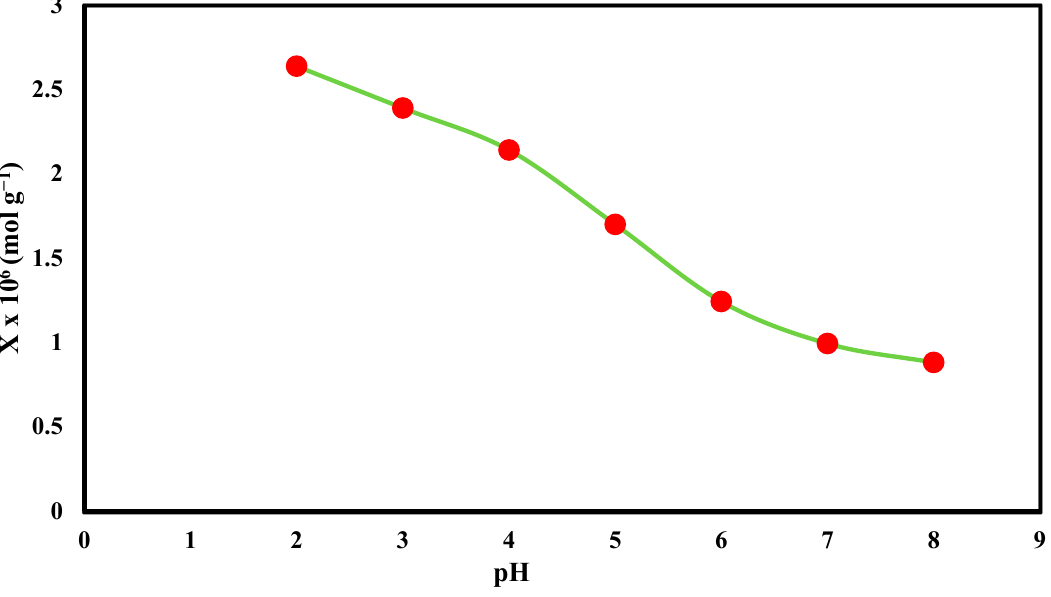
Figure 7. Effect of pH on arsenate adsorption onto MgO-IBC composite.